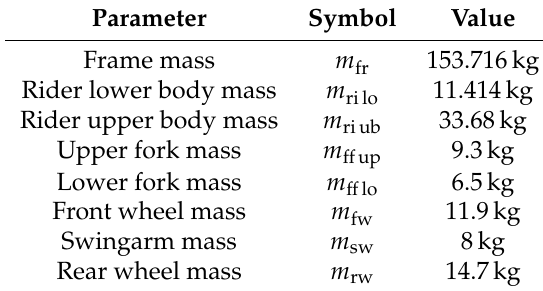
Table A6. Mass parameters.